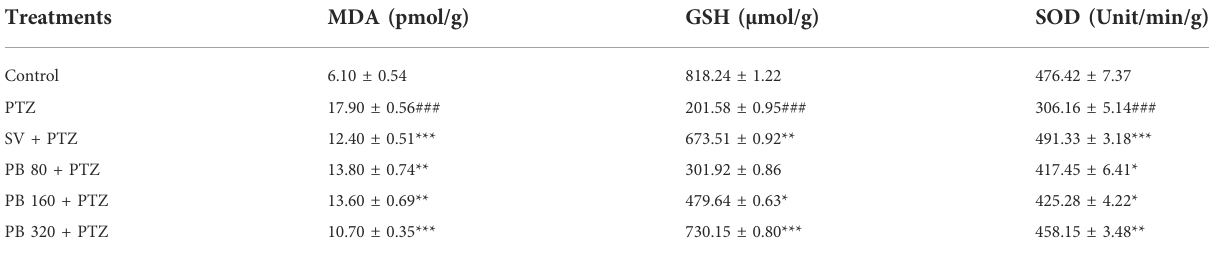
TABLE 2 The aqueous extract of P. biglobosa reduced oxidative stress markers parameters in the hippocampus.